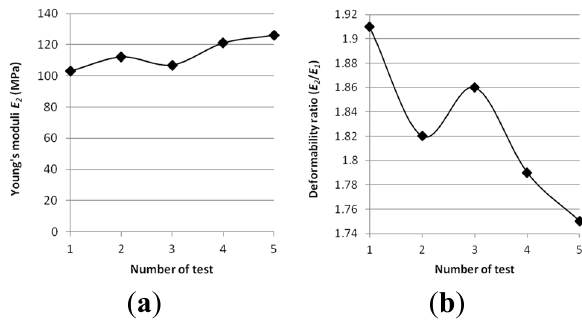
Figure 13. Results of Young’s moduli E 2 and deformability ratio I 0 for ground road improved by steel slag. ( a ) Young’s moduli versus number of static plate VSS tests.